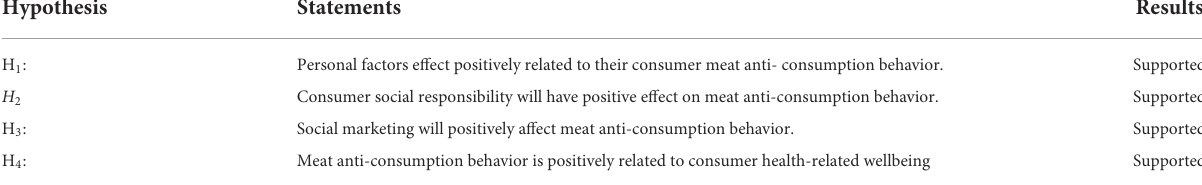
TABLE 6 Hypothesis supported/ not